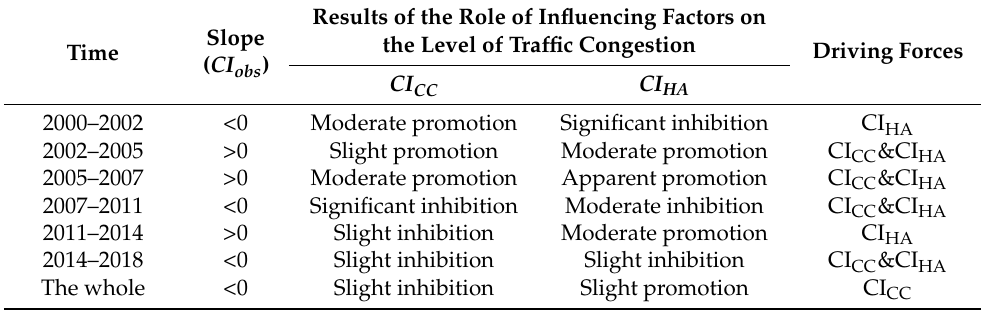
Table 9. The analysis results of driving